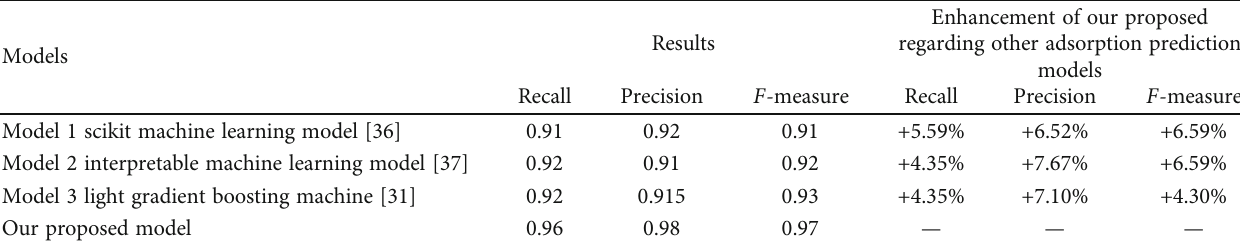
Table 6: Recall, precision, and F -measure metric comparison.